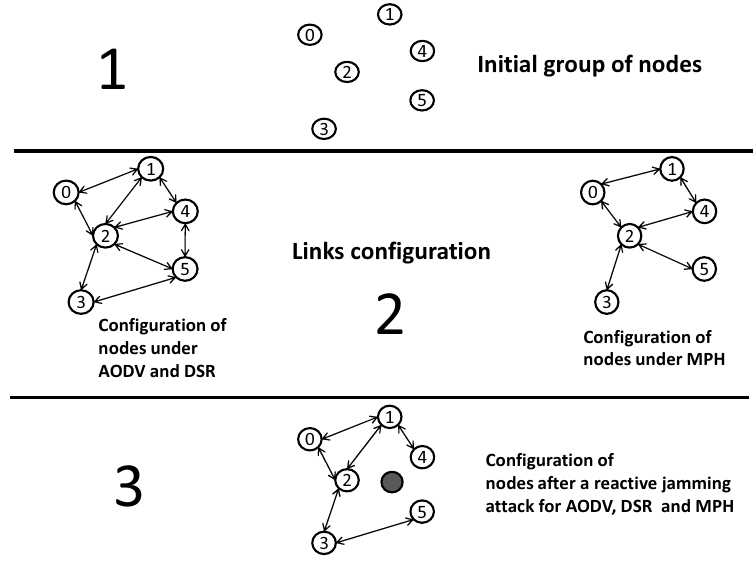
Figure 2. Self-configuring WSNs: AODV, DSR and MPH under a reactive jamming